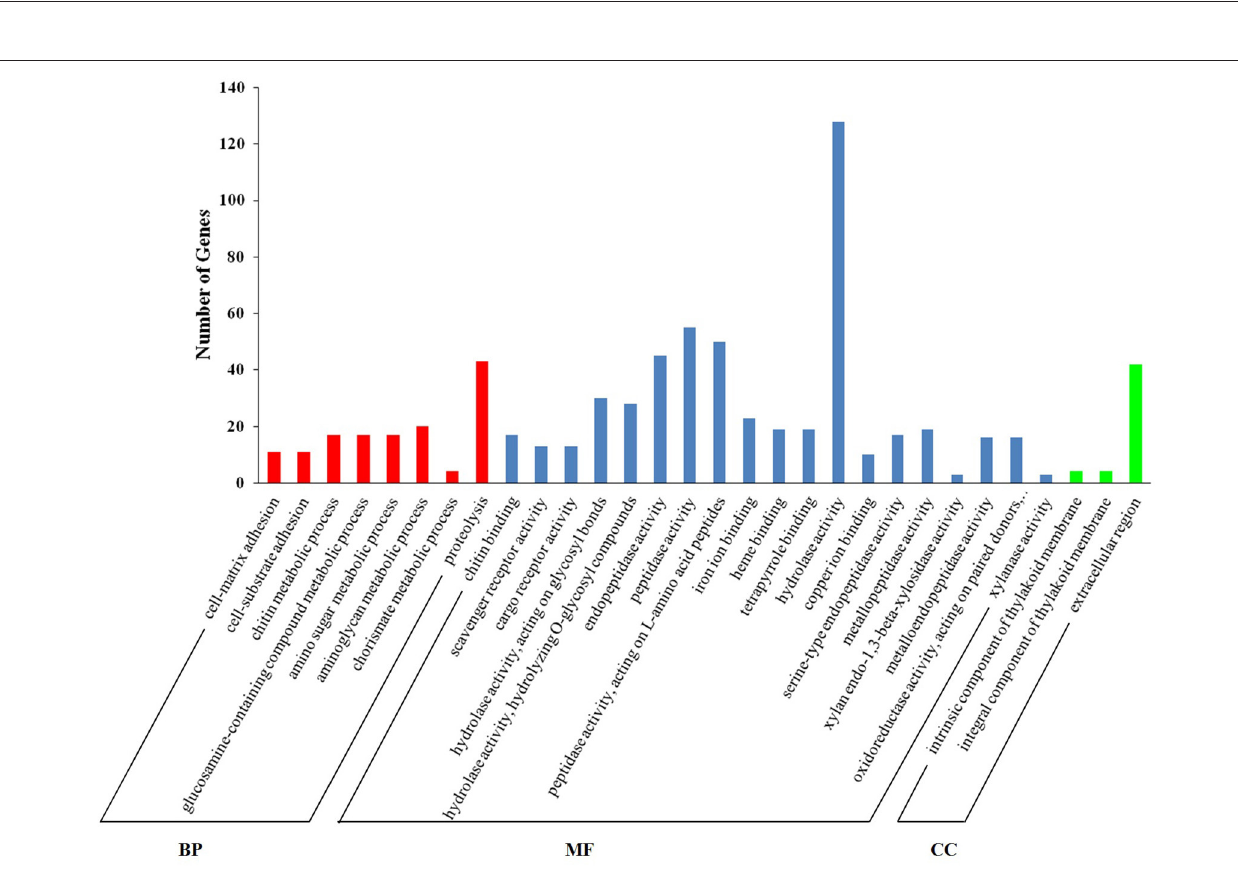
Frontiers in Marine Science |